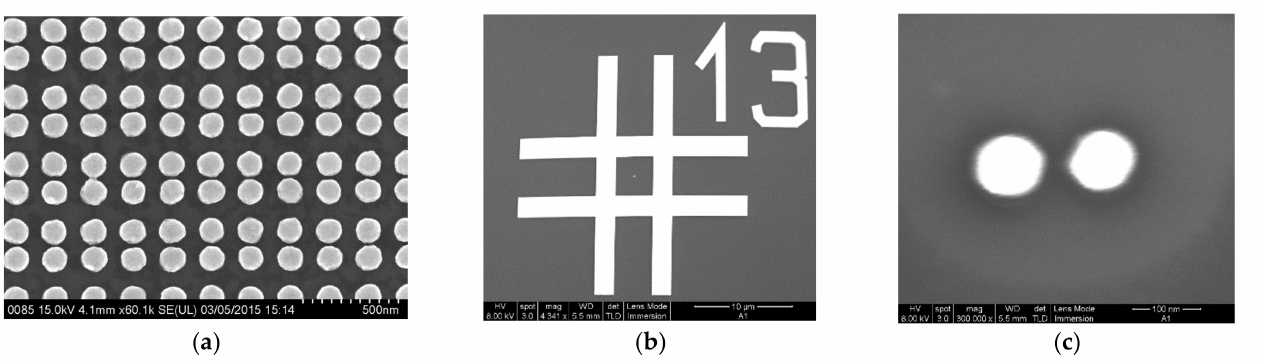
Figure 2. ( a ) Representative high-resolution SEM image of an Au dimer array with a period of 200 nm and a nanodisk diameter of 130 nm. ( b ) SEM image of a single dimer placed in the center of the cross marked as 13. ( c ) Zoomed SEM image of single dimer from ( b ) with nanodisk diameter of 90 nm and a distance (center to center) between nanodisks of 150 nm.